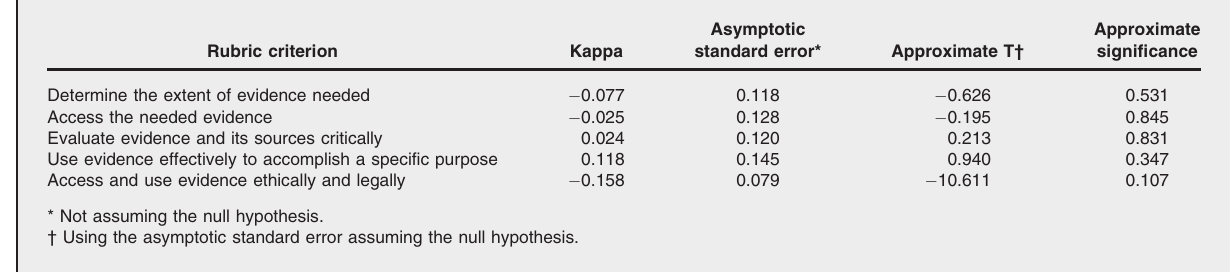
Inter-rater reliability for scoring of patient case